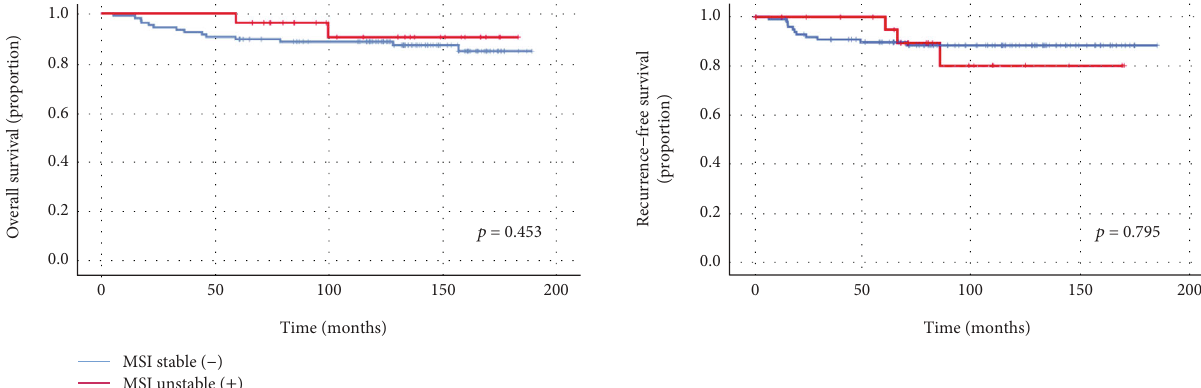
Figure 3: Survival curves of patients according to microsatellite instability (MSI)